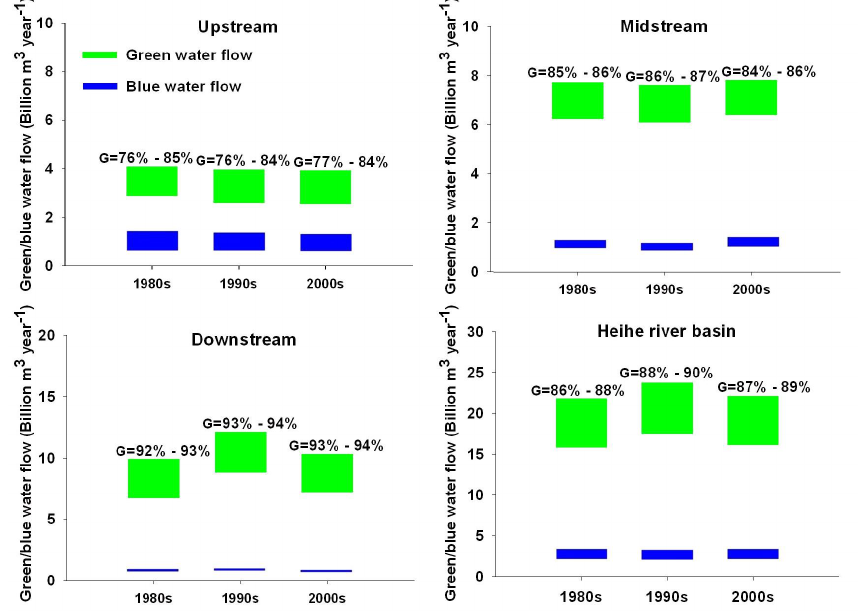
Fig. 4. The total water flow and green water coefficients from the 1980s to the 2000s in the Heihe river basin ( G is green water